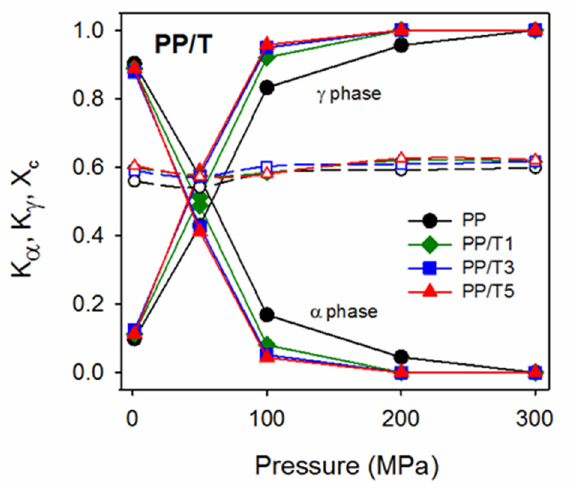
Figure 7. Phase contents in crystalline phase, K α and K γ (solid lines, filled symbols), and crystallinity degree, X c (dashed lines, empty symbols), of neat PP and PP/T nanocomposites crystallized during cooling under various pressures.